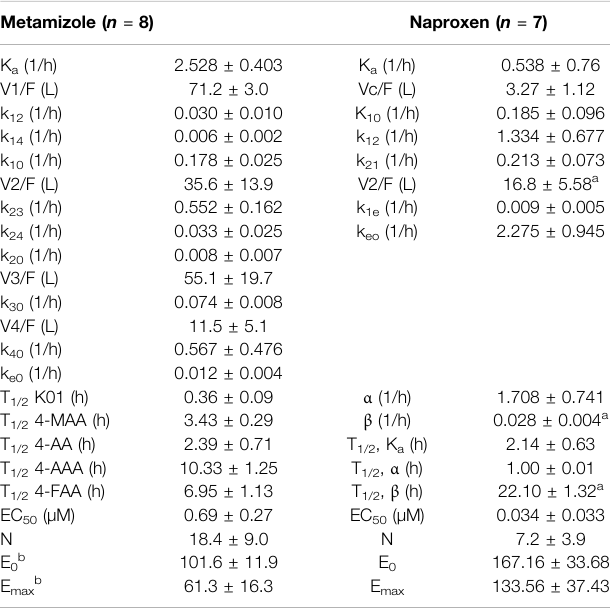
TABLE 3 | Parameters of the pharmacokinetic and pharmacodynamic models for metamizole and naproxen. The model is described in the methods section. Values are presented as mean ±